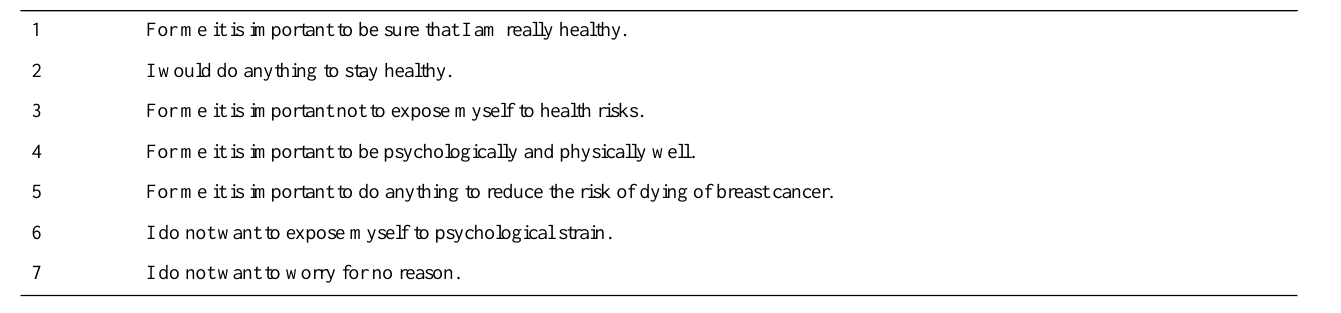
Table 4. Need for well-being scale.